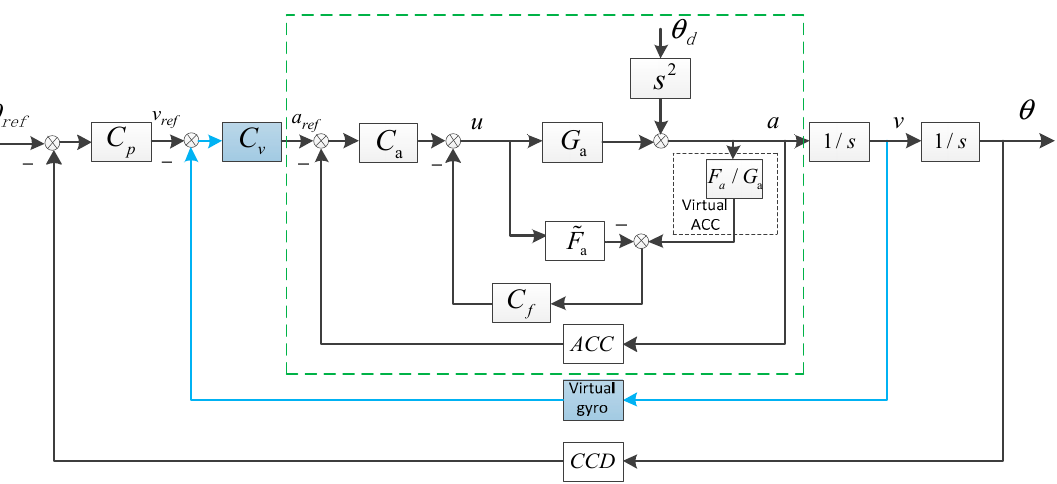
C are respectively the velocity controller and Figure 4. The TLC structure with FDOB. C and p Figure 4. The TLC structure with FDOB. C v and C p are respectively the velocity controller and position v θ controller. θ ref respects the given position. θ is the output respects the given position. θ is the output position. position controller. ref